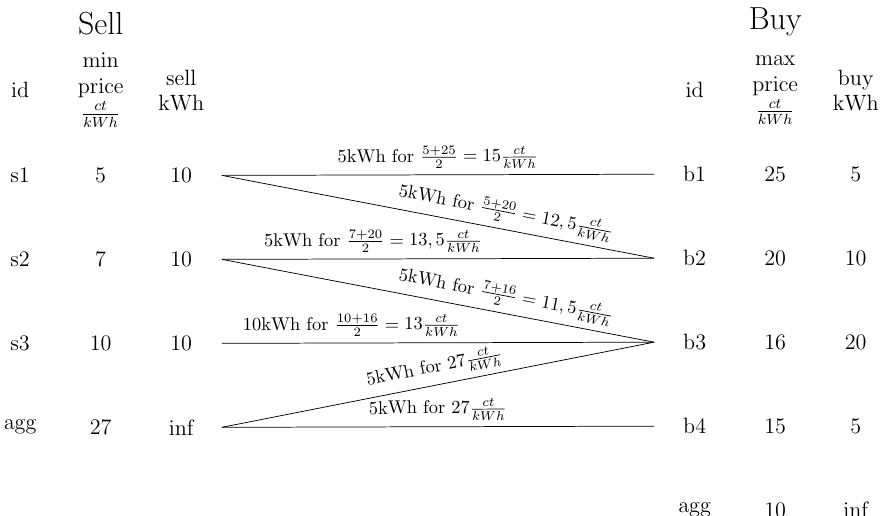
Figure 3. Clearing mechanism for limit orders. The matching is done from top to bottom. Starting with the first buyer b1 , the demand of 5 kWh is met by the first seller s1 , which then has 5 kWh left to sell. This one is used for the demand of the second buyer b2 and so on.